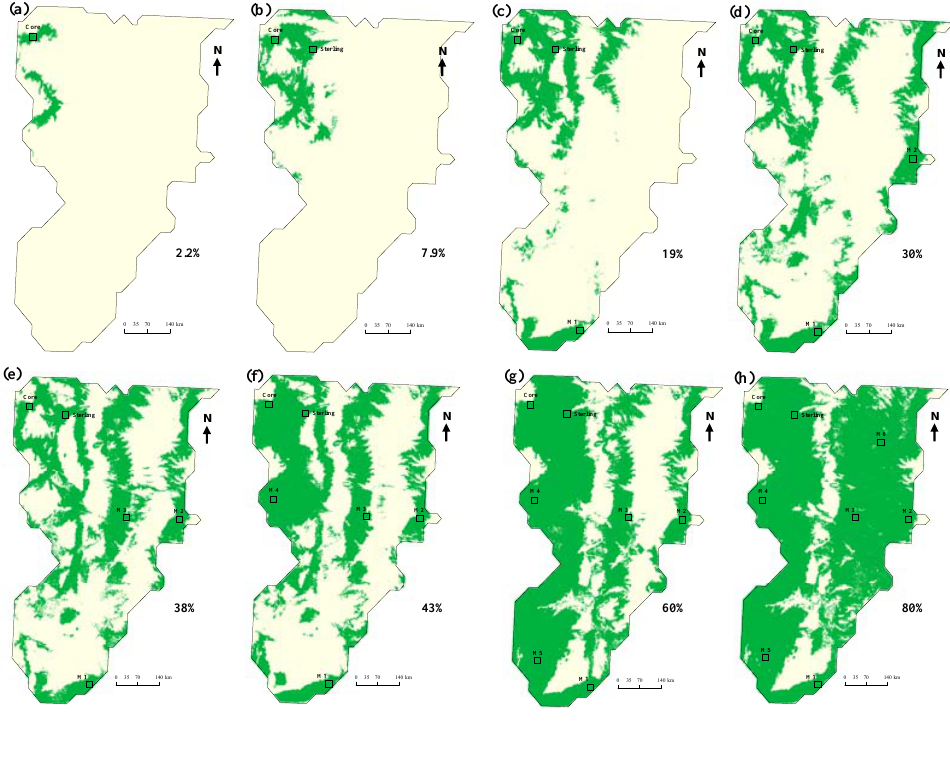
Figure 3. Iterative Maxent models, subsequent selection of new sample sites (numbered in consecutive order; M1 to M6), and similar (green) and dissimilar (blue) area at each step. Numbers next to each figure show the percentage of the domain’s environmental envelop that was captured by Maxent Dissimilarity